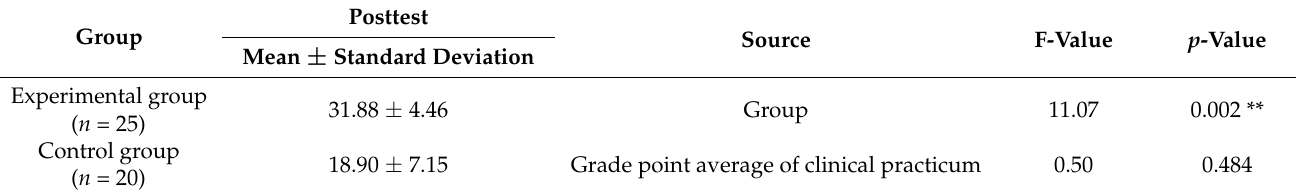
Table 7. Analysis of covariance of clinical competency between experimental and control groups ( n = 45). Posttest Group Source F-Value p -Value Mean ± Standard Deviation Experimental group 31.88 ± 4.46 Group 11.07 0.002 ** ( n = 25) Control group 18.90 ± 7.15 Grade point average of clinical practicum 0.50 ( n = 20)